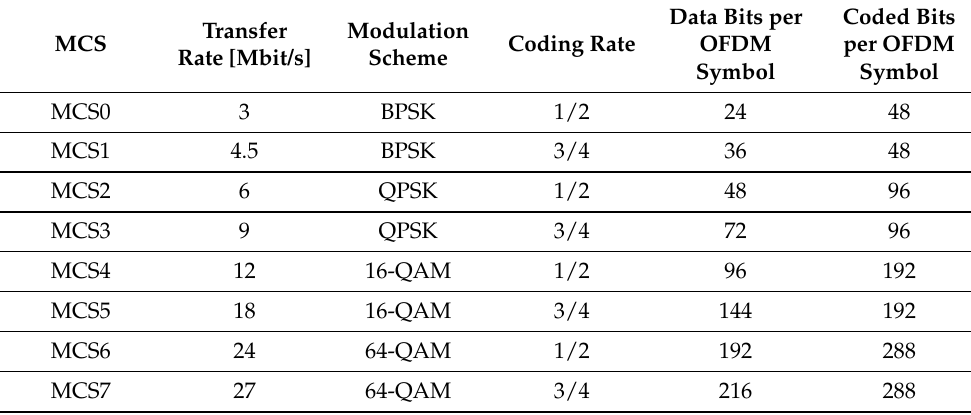
Table 1. Transfer rates, modulation schemes and coding rates in 802.11p